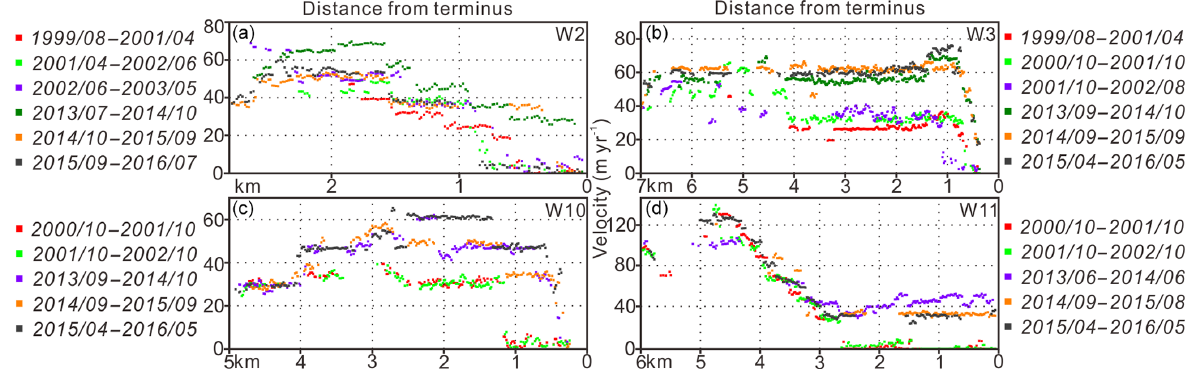
Figure 5. Centre line annual-velocity profiles for advancing glaciers: (a) W2, (b) W3, (c) W10, and (d)